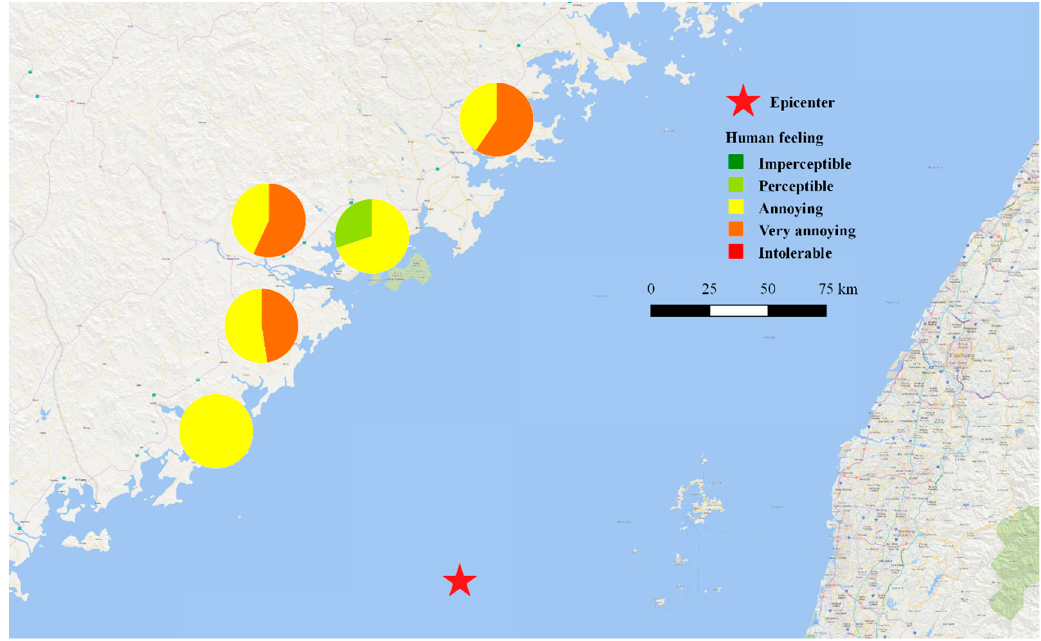
Figure 6. Distribution of human uncomfortableness under the ground motions of the 11 / 26 / 2018 M6.2 Taiwan Strait